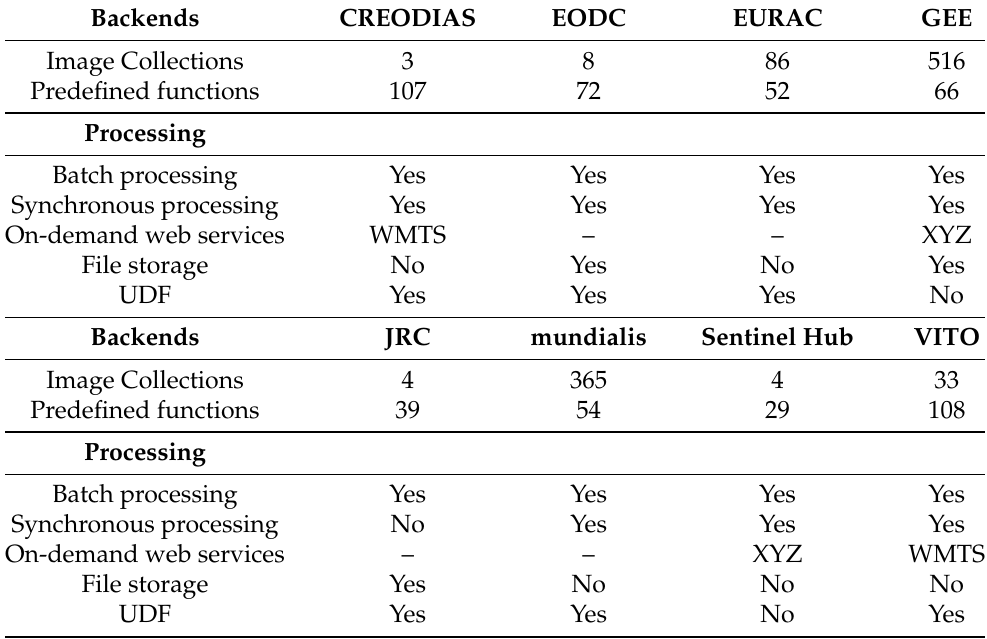
Table 1. Current characteristics of openEO compatible backends. Image collections do not reflect overall available EO data at the platform but data provided by the backend. The Joint Research Centre (JRC) backend is currently not publicly